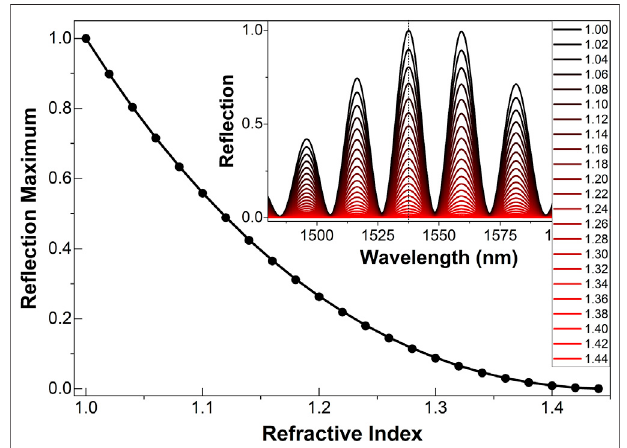
FIGURE2| Calculatedmaximaoftheinterferencepatterns(dots)shown in the inset graph as a function of the refractive index. The continuous line is a fi tting to the data. The list of values shown in the table are values of n dotted vertical line shown the maxima of the interference patterns.